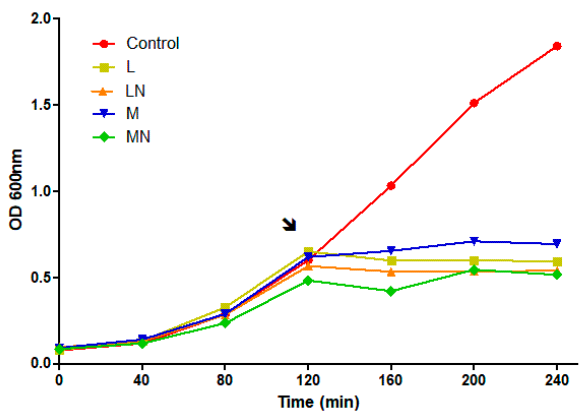
Figure 1. Escherichia coli growth curve in the presence of chitosan polymers and nanoparticles. The DH5 α strain was grown in Luria–Bertani medium at 37 ◦ C and 180 rpm. The black arrow indicates the addition of medium (M), and low molecular (L) polymers or MN LN nanoparticles in order to reach final concentration of 3 × minimum inhibitory concentration (MIC) values, of 1.41, 0.9, 1.2 and 0.9 mg / mL, of CS polymers / nanoparticles